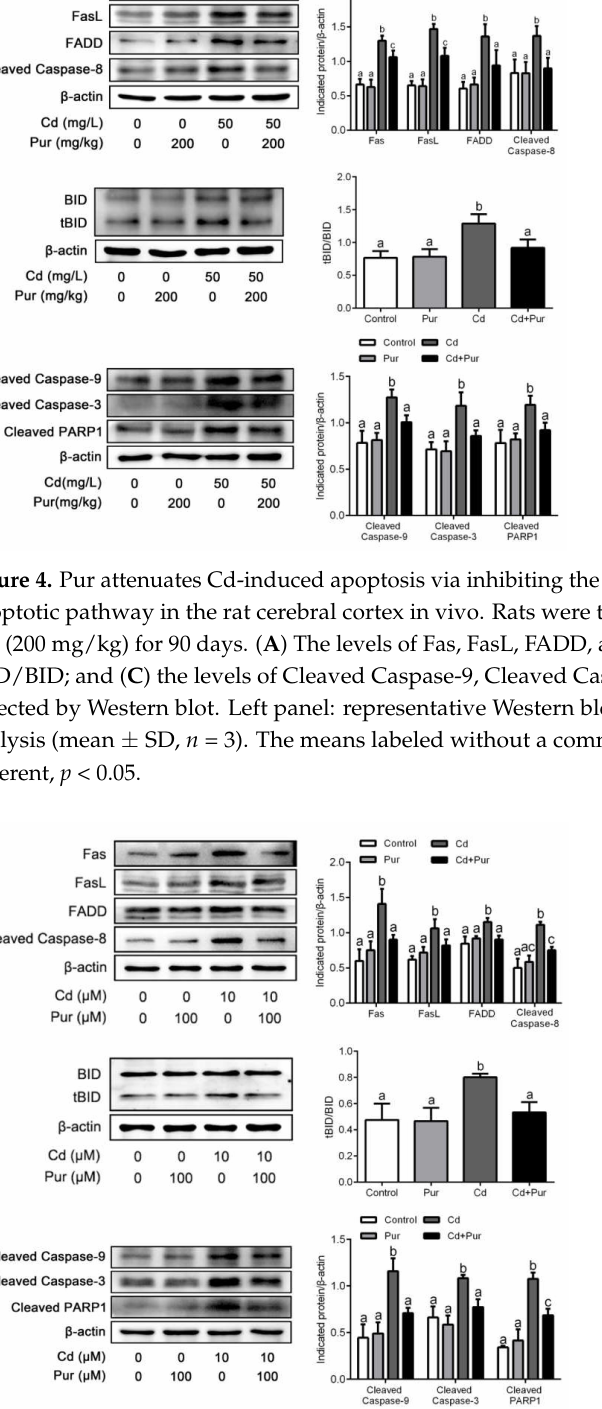
Figure 5. Pur attenuates Cd-induced apoptosis via inhibiting the Fas/FasL-mediated mitochondrial apoptotic pathway in primary cortical neurons in vitro. Primary cortical neurons were pretreated with 100 µ M Pur for 1 h, followed by 10 µ M Cd exposure for 12 h. ( A ) The levels of Fas, FasL, FADD, and Cleaved Caspase-8; ( B ) ratio of tBID/BID; and ( C ) the levels of Cleaved Caspase-9, Cleaved Caspase-3, and Cleaved PARP1 were detected by Western blot. Left panel: representative Western blot image; right panel: quantitative analysis (mean ± SD; n = 3). The means labeled without a common letter (a, b, c) are significantly different, p <